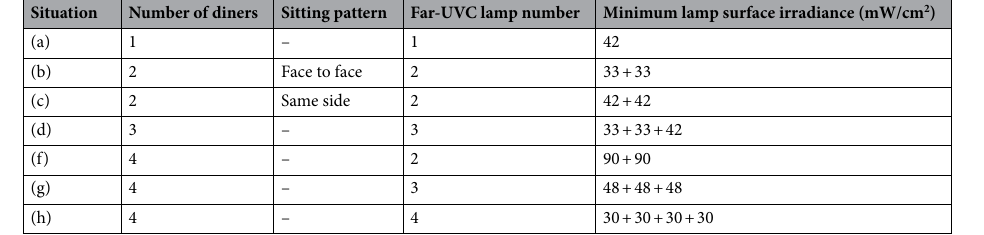
Table 1. Minimum irradiance required for far-UVC lamps under different dining